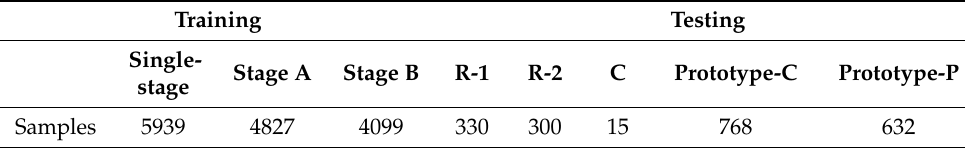
Table 2. Training and testing datasets for insulator detection